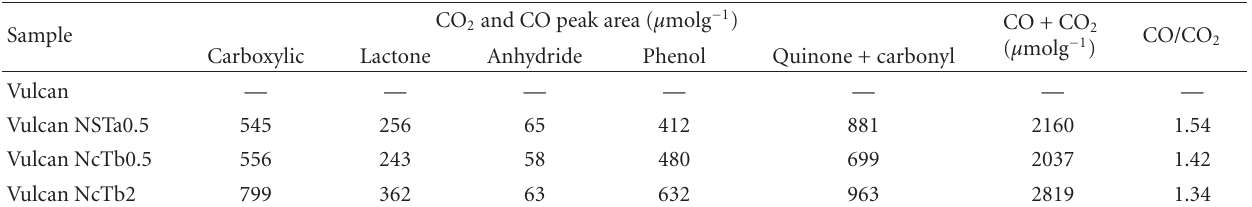
Table 2: Quantification of surface oxygen groups as CO and CO 2 amounts desorbed during the TPD experiments. Sample